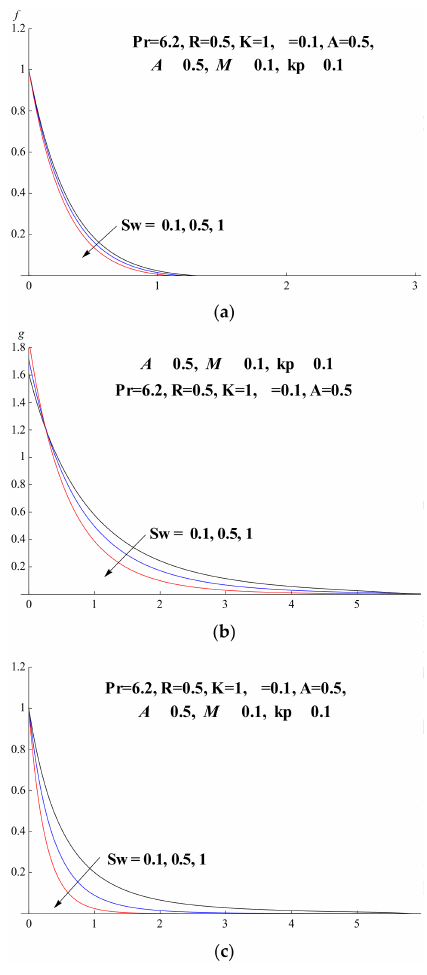
Figure 5. Influence of suction parameter ( Sw ). ( a ) Velocity profile, ( b ) angular velocity profile, and ( c ) temperature